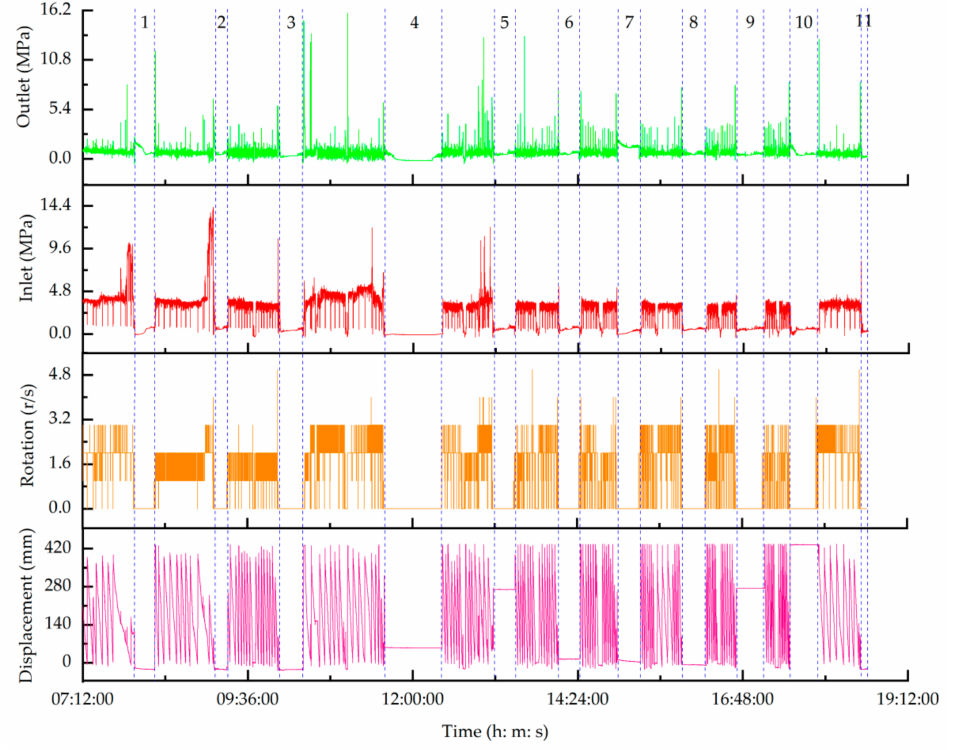
Figure 7. Rock-breaking response information–drilling time curves of a drilling rig drilling in Yan’an city on 10 September 2018 (drilling depth: 29.34–87.01